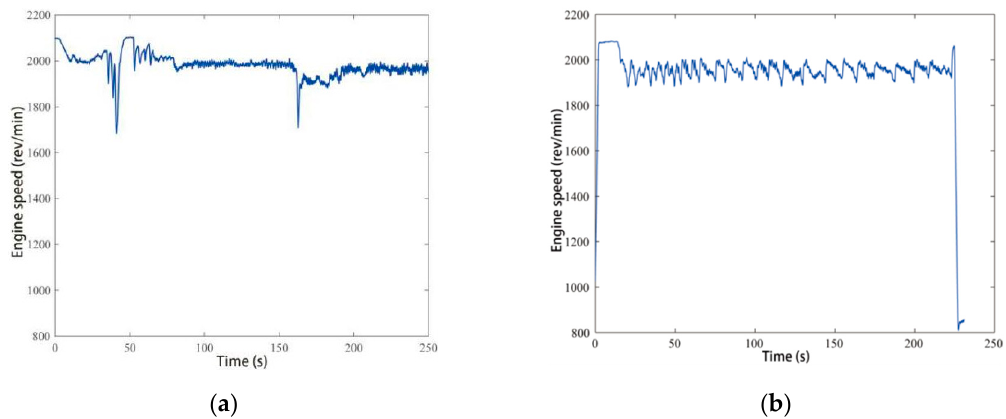
Figure 12. Engine speeds of ( a ) proportional-integral-derivative (PID) controller and ( b ) the proposed adaptive power controller.